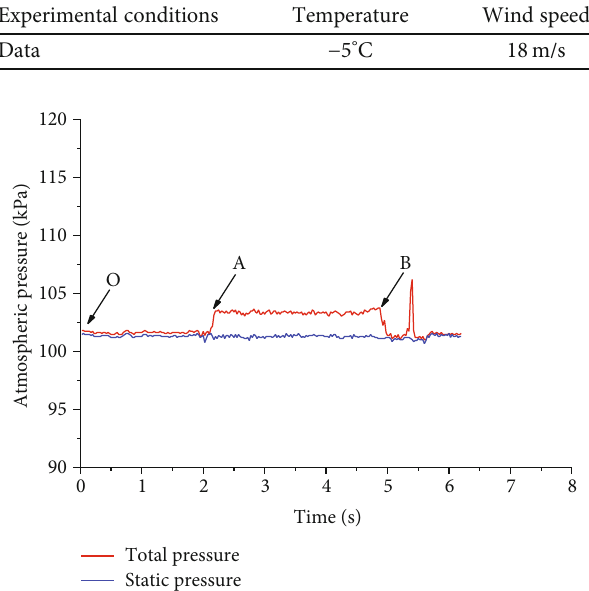
Figure 6: Pitot tube blocked by rime ice.